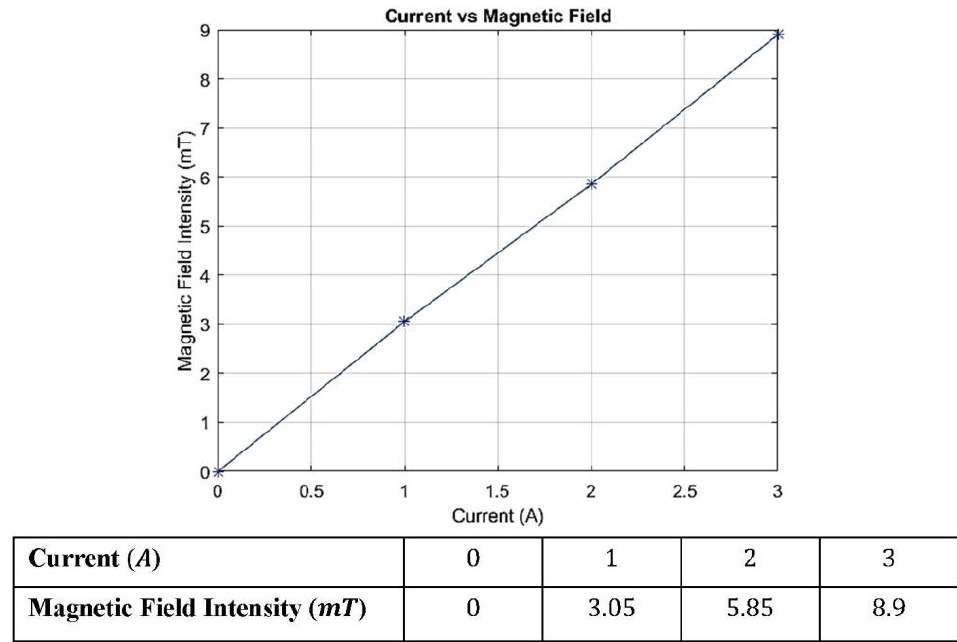
Figure 9. The magnetic field generated within the electromagnetic coils against the supplied current.